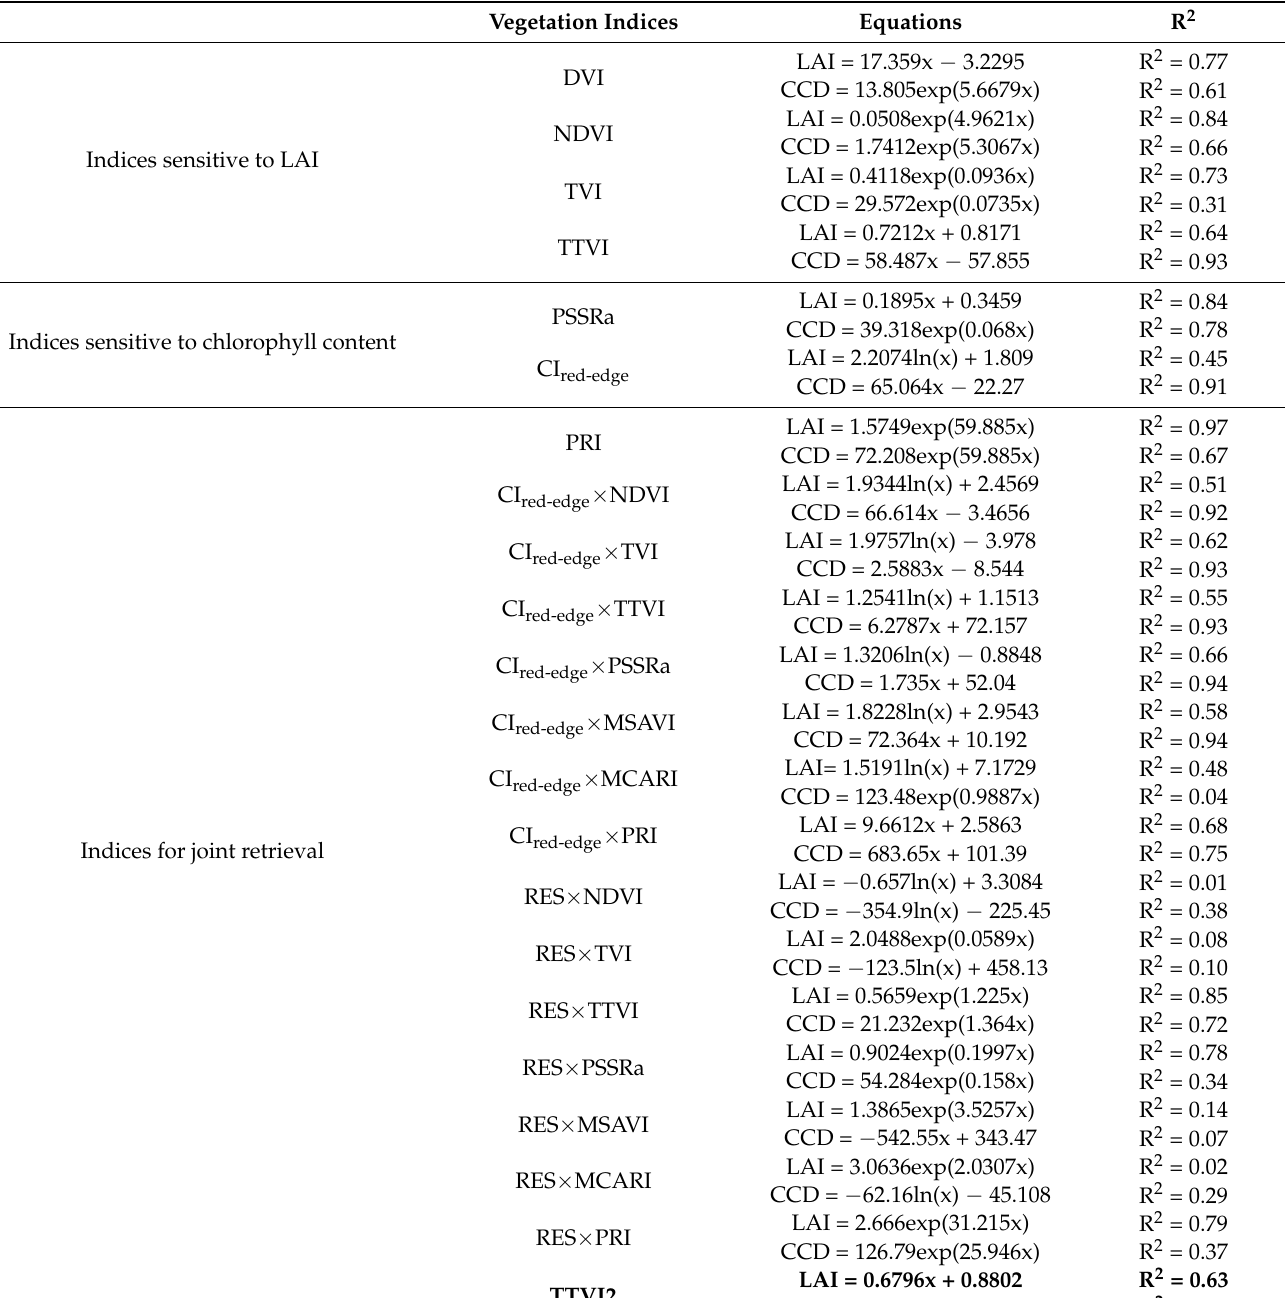
Table 4. The best-fit models for PROSAIL-derived indices and vegetation